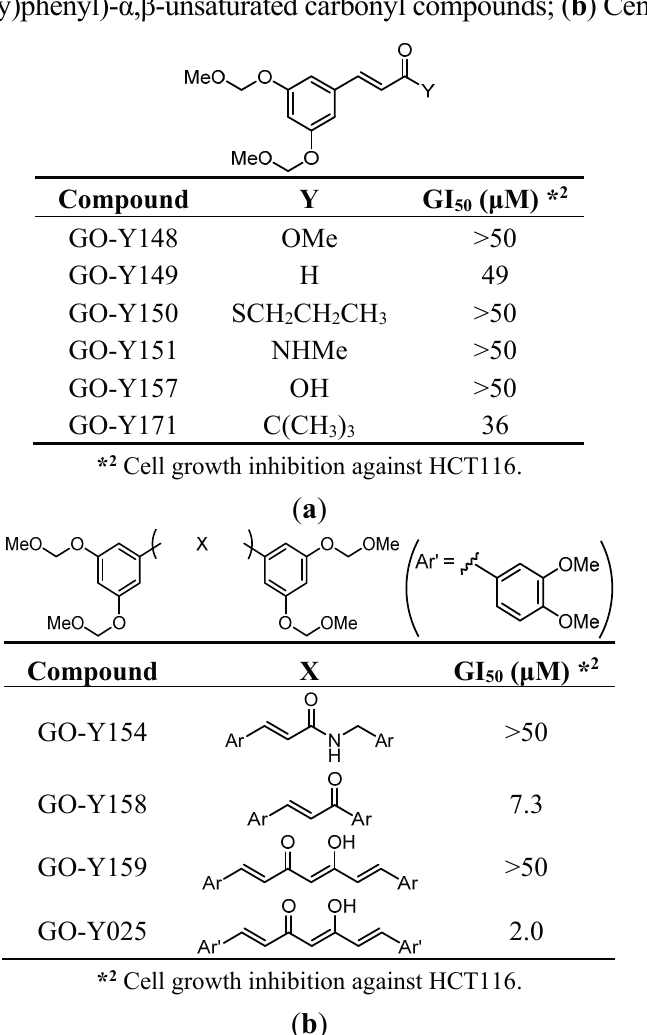
Table 3. SAR of α , β -unsaturated carbonyl: different reactivities and lengths. ( a ) ( E )- β